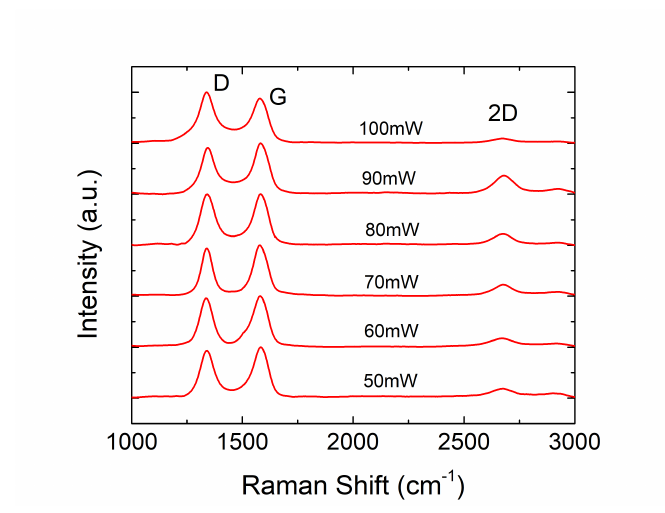
Figure 4. Raman spectra acquired from the laser-treated Kapton R (cid:13) for different laser powers (wavelength: 532 nm, data interval: 1 cm − 1 , exposure time: 15 s, accumulations: 5, center number: 1469.99 cm − 1 ).